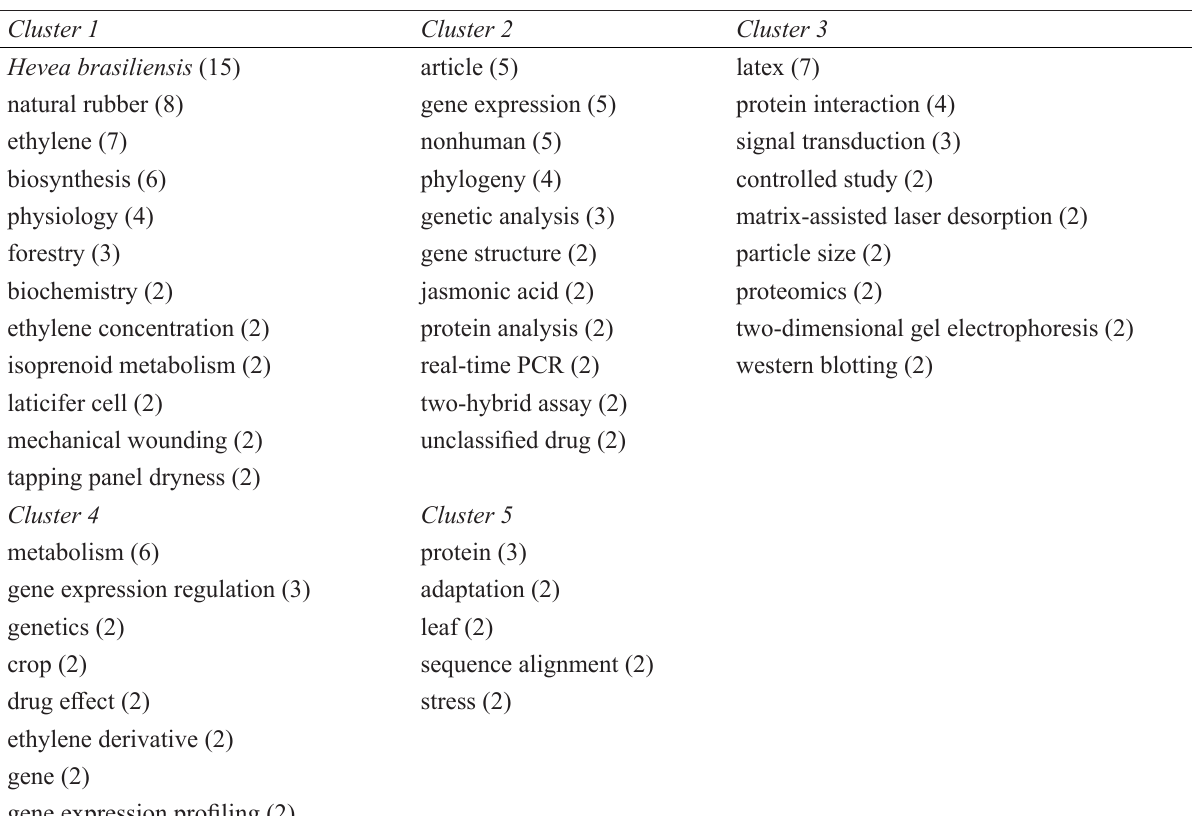
Table 3 Keyword clusters in research related to oxidative stress induced by harvesting practice (n = 16). Data were derived from VOSviewer with two minimum occurrences. The number in brackets expresses the